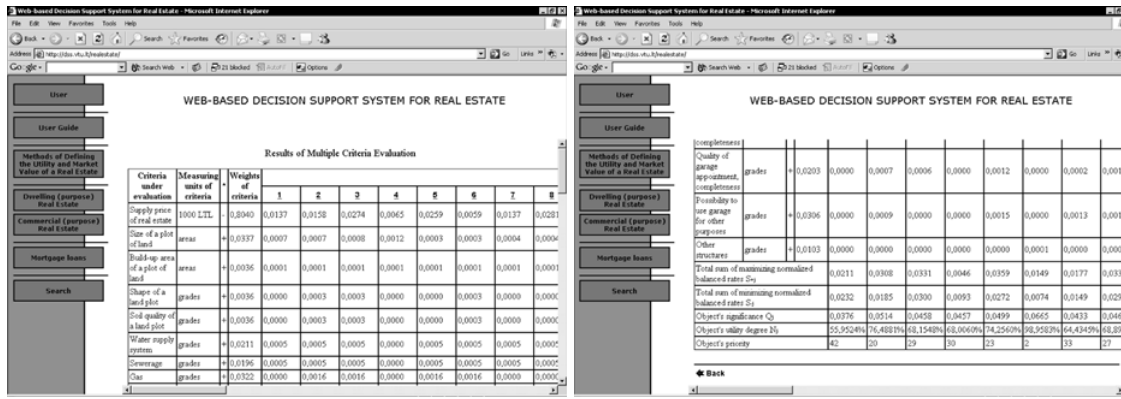
Figure 3. Results of multiple criteria evaluation of the private house’s alternatives: upper part of the matrix for obtained results ( left ); lower part of the matrix for obtained results ( right